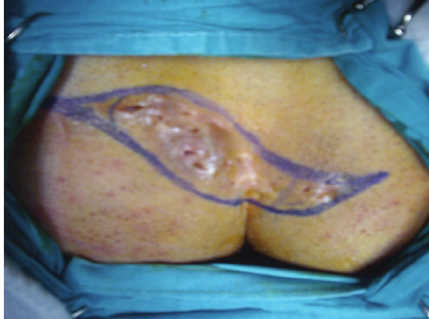
Figure 2: Landmarks of the